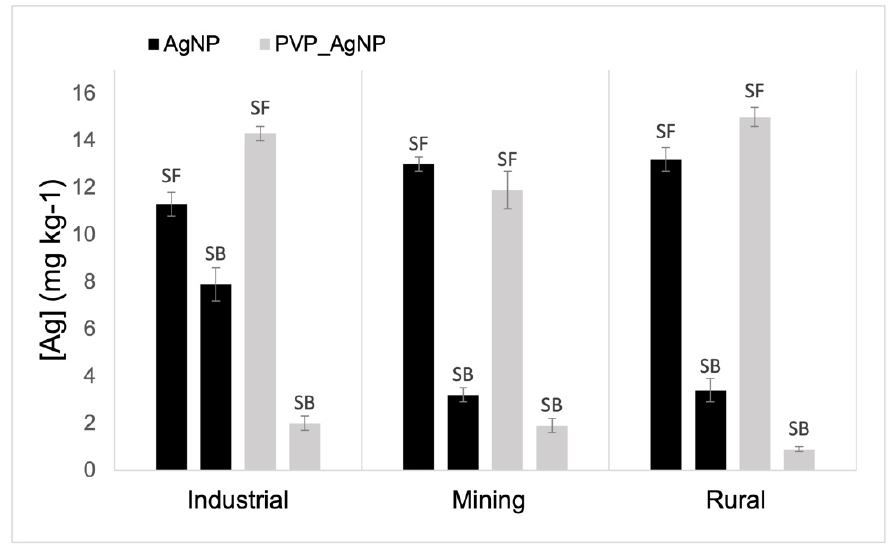
Figure 3. Total concentration of Ag (mg kg − 1 , d.w.), in upper (SF) and bottom layers (SB) of the three soils (mining, industrial and rural) collected from pots after 30 days of treatment with AgNP or PVP-AgNPs.